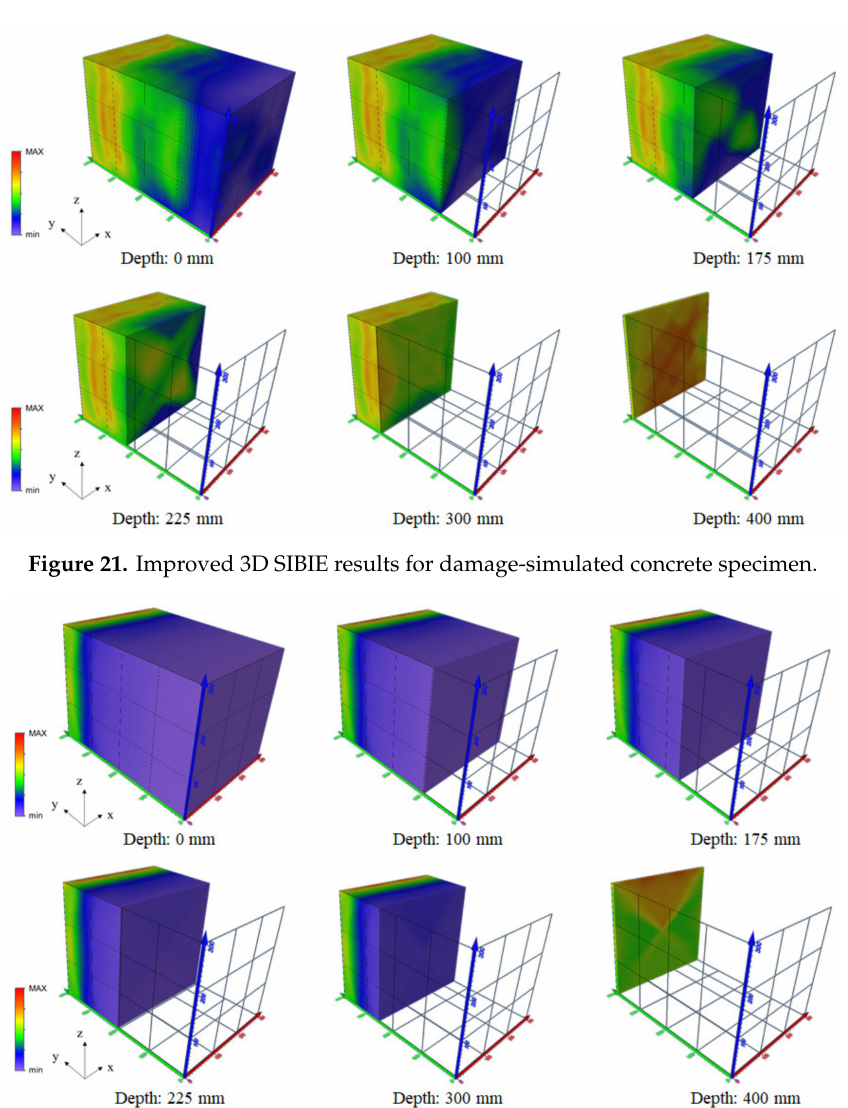
Figure 22. Improved 3D SIBIE results for intact concrete